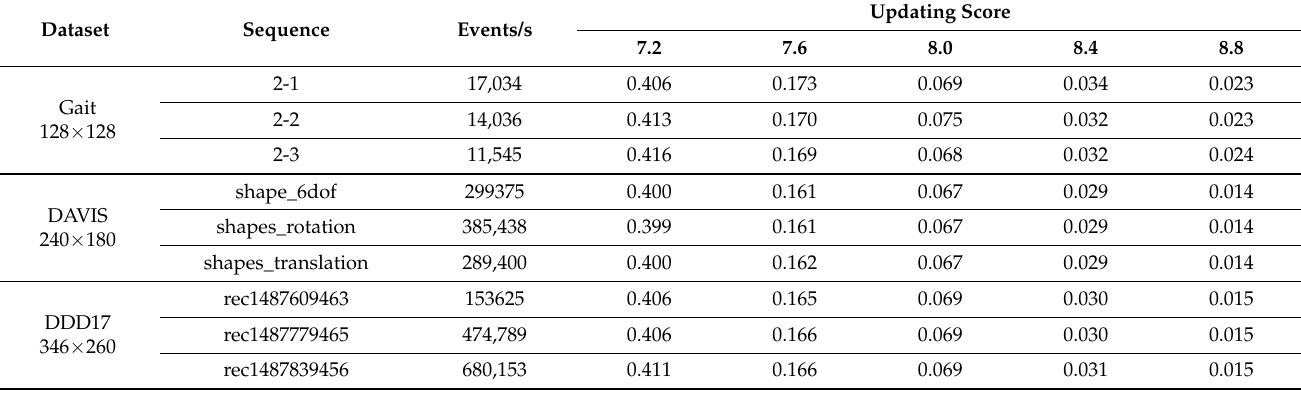
Table 5. Time ( µ s) spent on encrypting one event on cloud server ( K = 152,031,121) using different updating scores and NVSs with different resolutions.